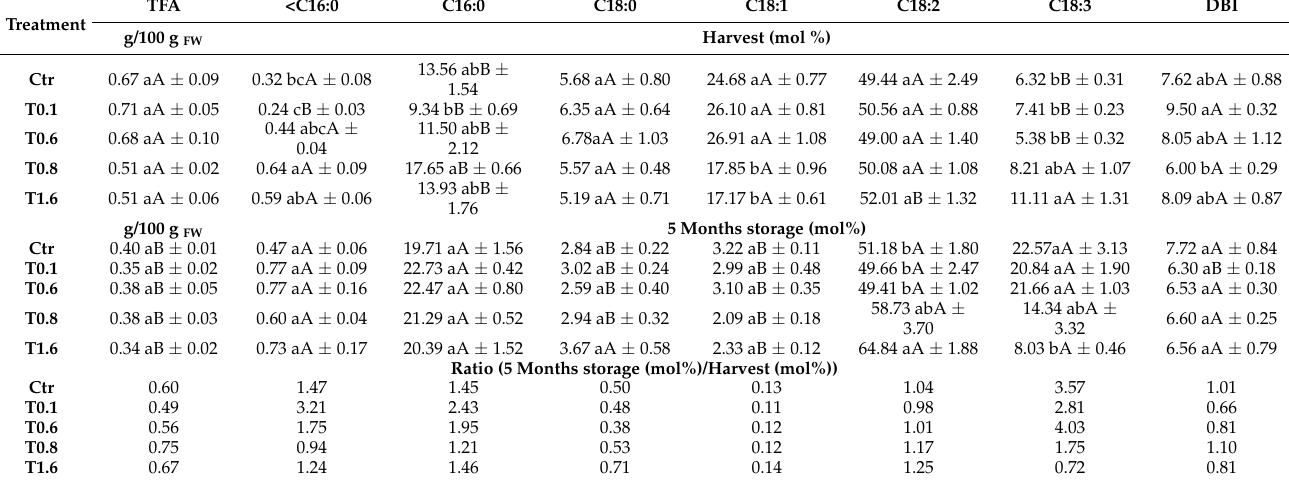
Table 3. Average ± S.E. of total fatty acid content (TFA), fatty acids profiles (relative abundance, mol %) and double bound index (DBI) of lipids from Rocha pear fruits at harvest and after 5 months of storage. Treatments Ctr, T0.1, T0.6, T0.8 and T1.6 correspond to the control and foliar spraying with 0.1 and 0.6 kg · ha − 1 Ca(NO 3 ) 2 and 0.8 and 1.6 kg · ha − 1 CaCl 2 , respectively. Letters a, b and c represent significant differences among treatments for each date, while A and B represent significant differences between harvest and 5 months of storage for each